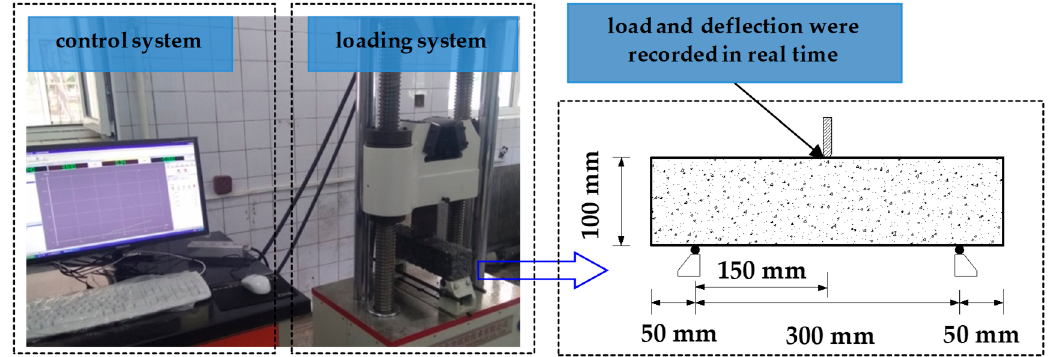
Figure 2. Permeability test apparatus.